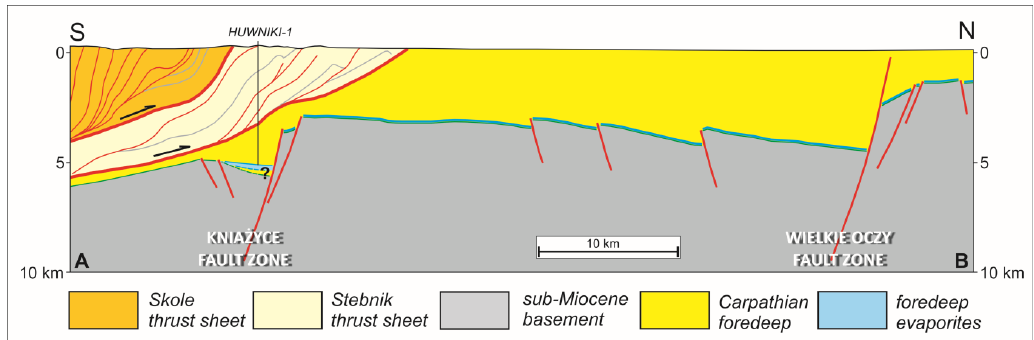
Figure 3. This seismo-geological cross-section shows the Carpathian orogenic wedge’s frontal part and its foredeep, after [18,19,21–23], modified. The Huwniki-1 well (see its location in Figure 1)